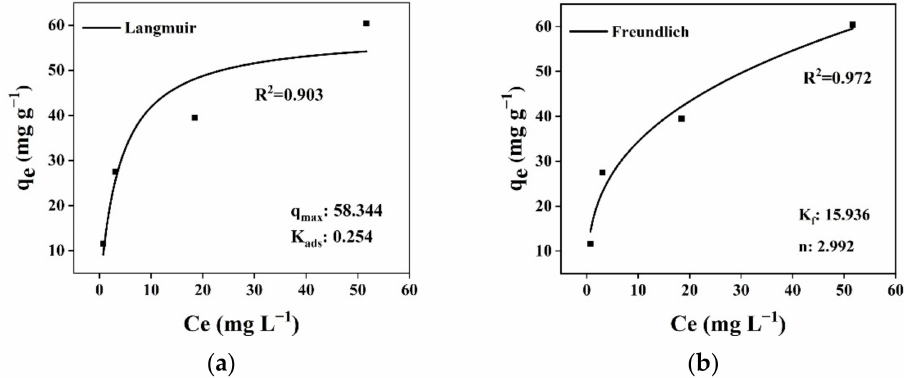
Figure 10. Nonlinear data fitting for Langmuir ( a ) and Freundlich ( b ) models for isothermal adsorp- tion of